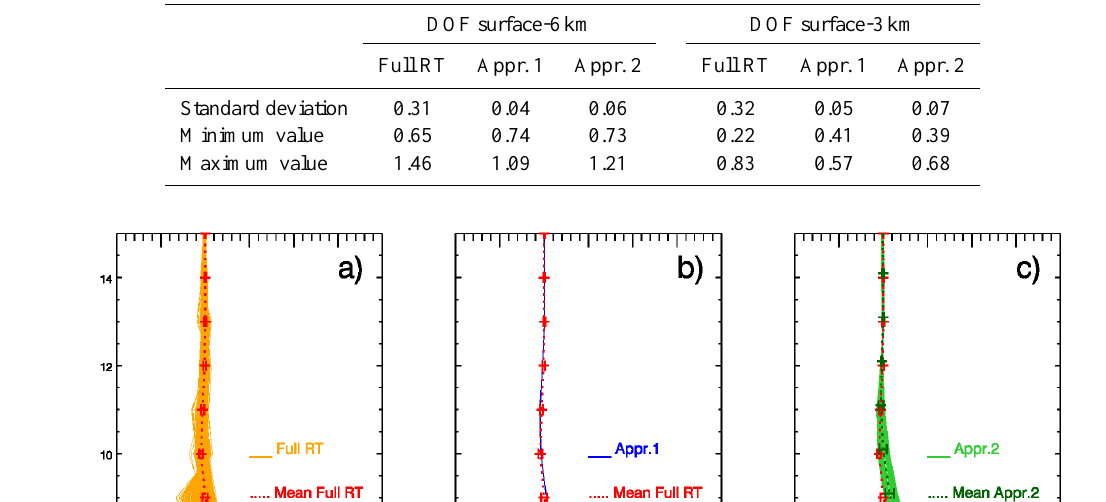
Table 1. Standard deviation, and maximum and minimum values for the DOF surface-6km and surface-3km, for full RT and approximated POs, for the 20 August 2009, 09:00UTC.